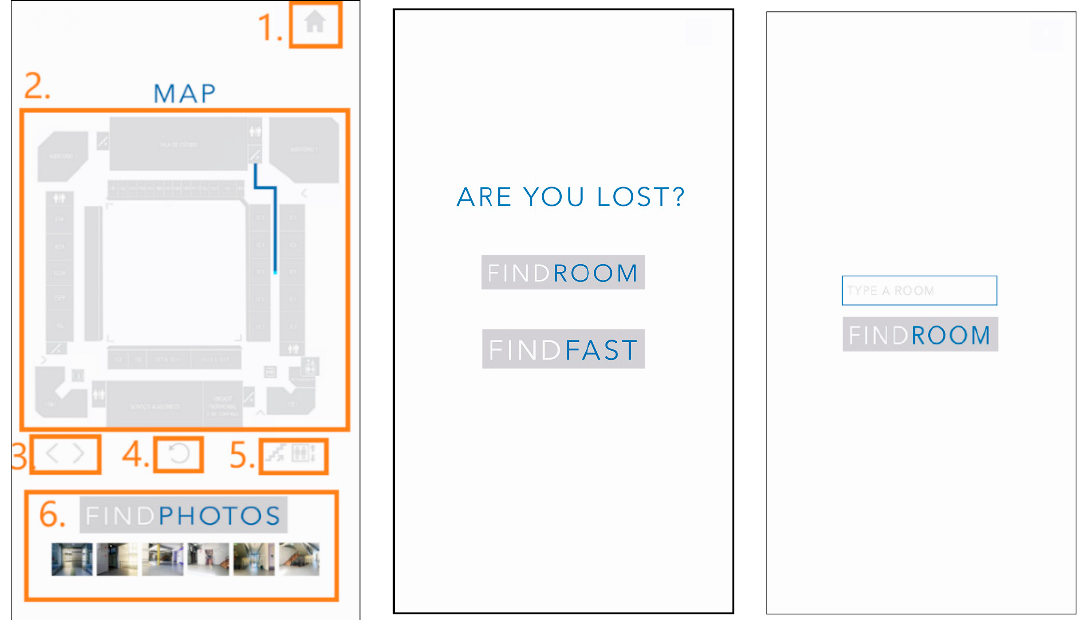
Figure 12. Floor Map view screen description ( Left ), Choose Destination options ( Center ) and FINDROOM option ( Right ).